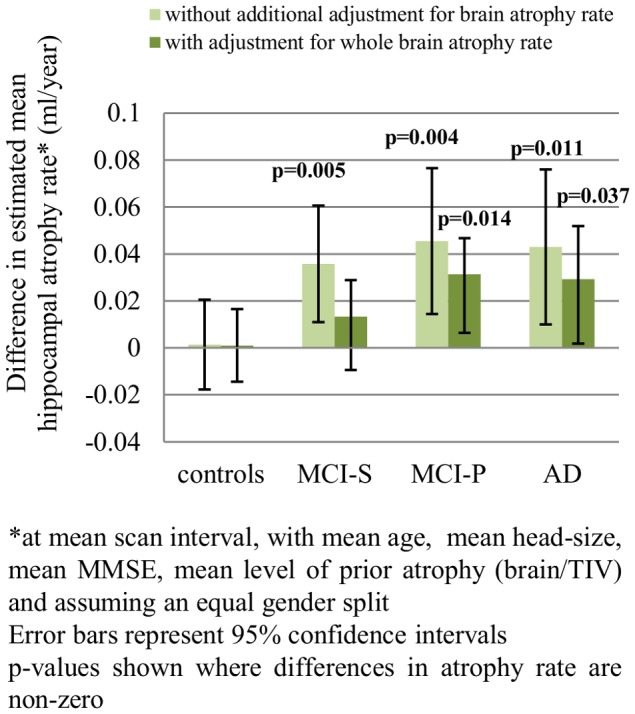
Difference in hippocampal atrophy rates*: ε4+ vs ε4-.